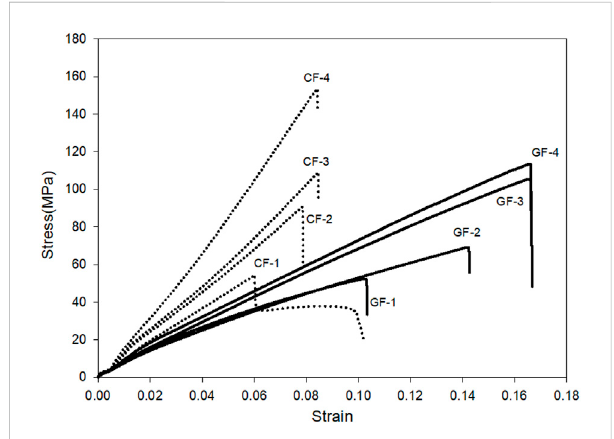
FIGURE 5 Stress-Strain curve depending on the number of reinforcement layers.